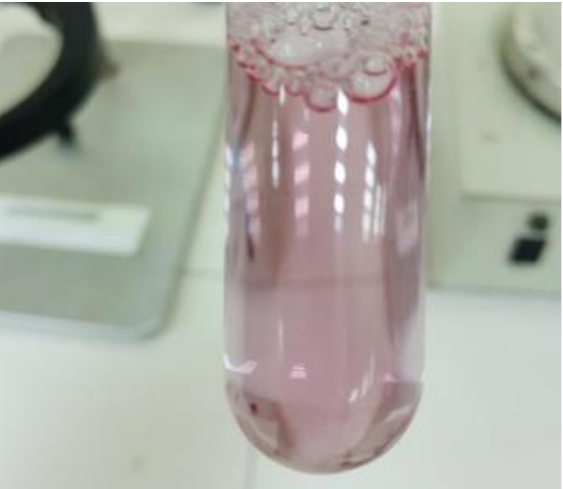
Figure 2. Dilution test (F1 formulation), indicating no phase separation after diluting with water.